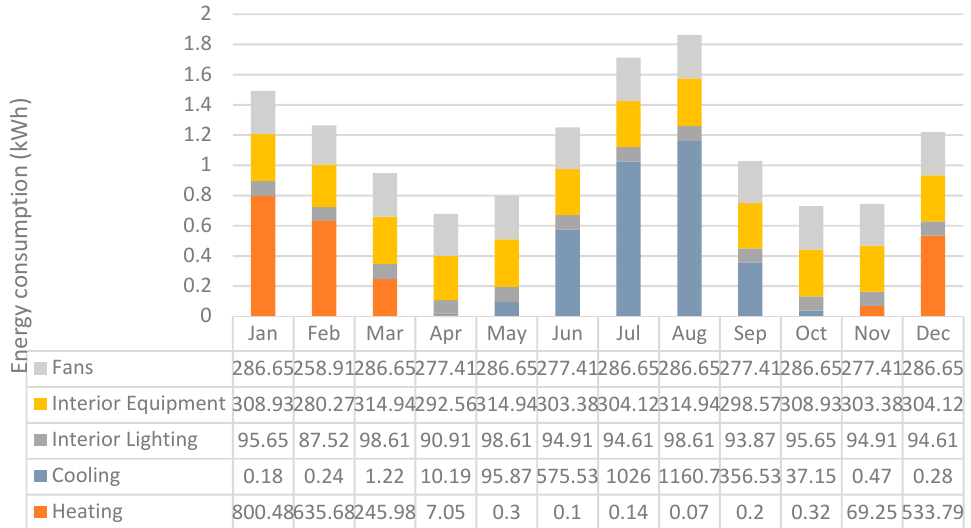
Figure 11. Energy consumption of various equipment of the CASE-X.